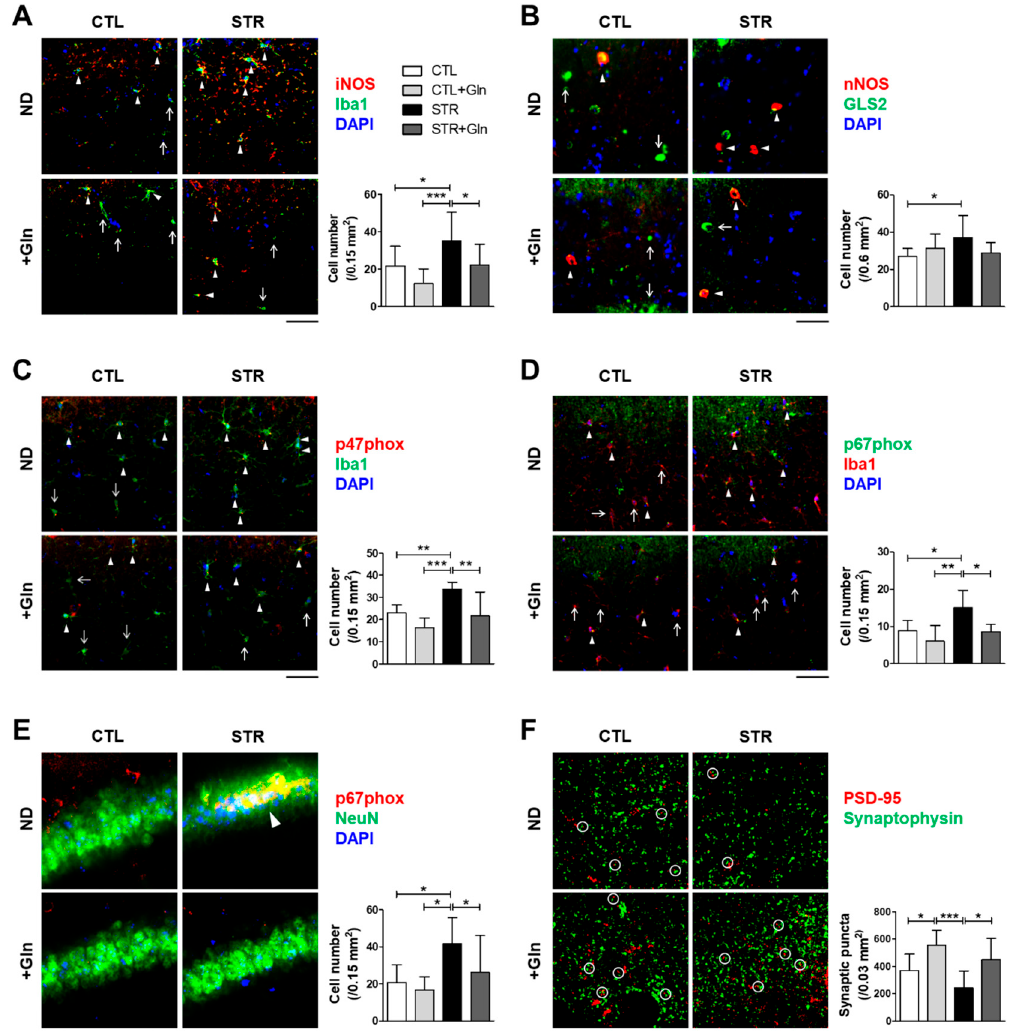
Figure 7. Glutamine (Gln) supplementation prevents both the increase in proteins related to chronic immobilization stress-induced reactive oxygen/nitrogen species (ROS/RNS), and the reduction of synaptic puncta in the hippocampal CA1 region. ( A–E ) Representative images of hippocampal immunohistochemistry for ROS/RNS production-related proteins with cellular markers (Iba1 for microglia and NeuN for neurons). Images were analyzed in the stratum radiatum ( A–D ) or the stratum pyramidale ( E ) in the CA1 region. Arrowheads indicate double-positive cells and arrows indicate cellular marker single-positive cells. Double-positive cell numbers are presented with the images. ( F ) Numbers of synaptic puncta colocalized with PSD-95 and synaptophysin (white circles) in the stratum radiatum CA1 are presented with representative images. Secondary antibody-only controls were performed to confirm specific binding of the primary antibodies (data not shown). * p < 0.05, ** p < 0.01, and *** p < 0.001 values in a one-way analysis of variance followed by Newman–Keuls multiple-comparison tests ( n = 16/group, A-F). Scale bars = 50 μ m. CTL, control; CTL+Gln, Gln-